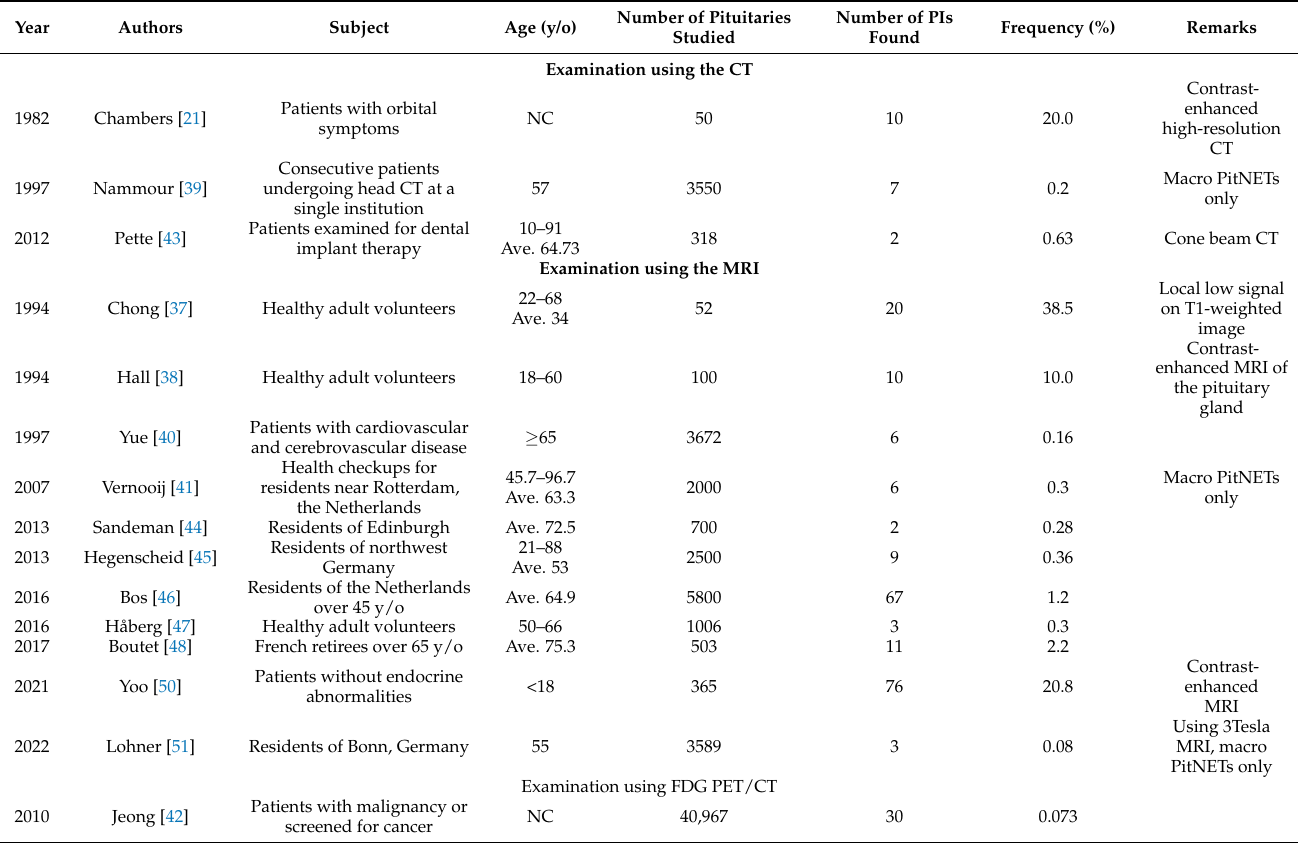
Table 2. Frequency of PIs detected during